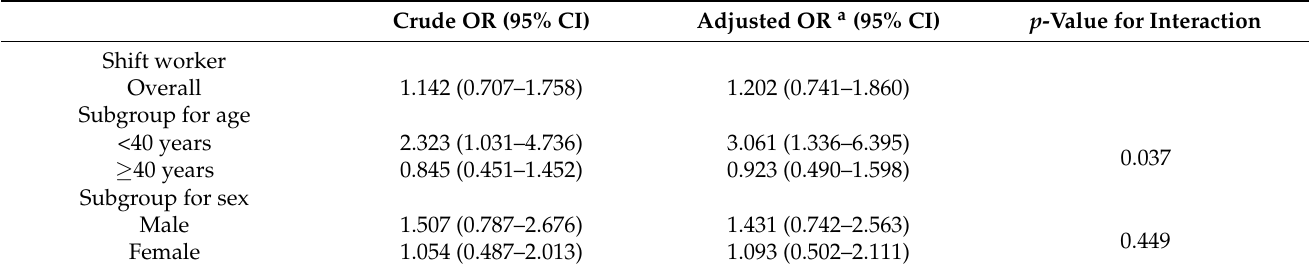
Table 2. Odds ratio (OR) of dry eye disease according to shift work by age group and sex. Crude OR (95% CI) Adjusted OR a (95% CI) p -Value for